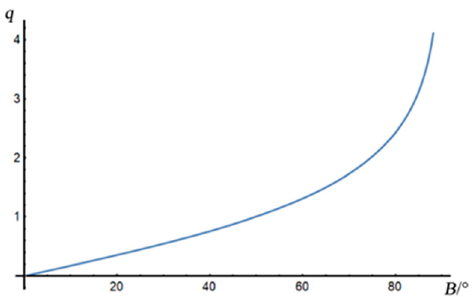
Figure 2. Sketch of isometric latitude q with geodetic latitude B .